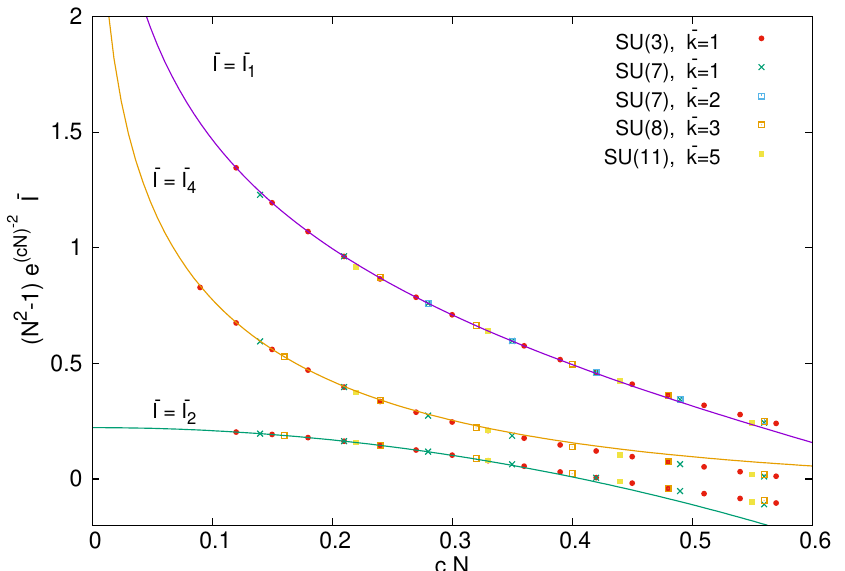
Figure 6. The integrals (cid:22) I 1 , (cid:22) I 2 and (cid:22) I 4 multiplied by the factor ( N 2 (cid:0) 1) e ( cN ) (cid:0) 2 as a function of cN . The continuous lines are given by formulas (5.18){(5.20).